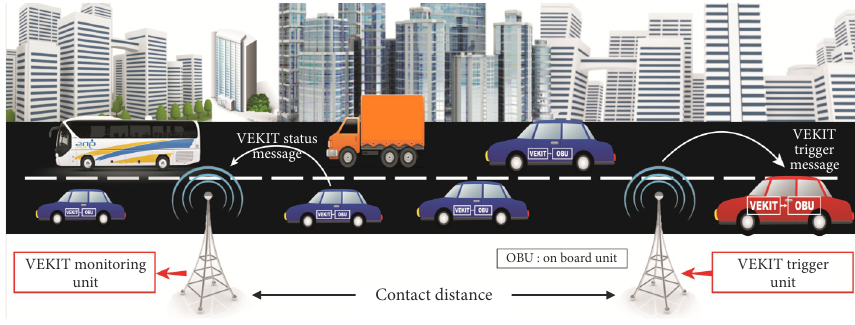
Figure 3. VEKIT monitoring scenario